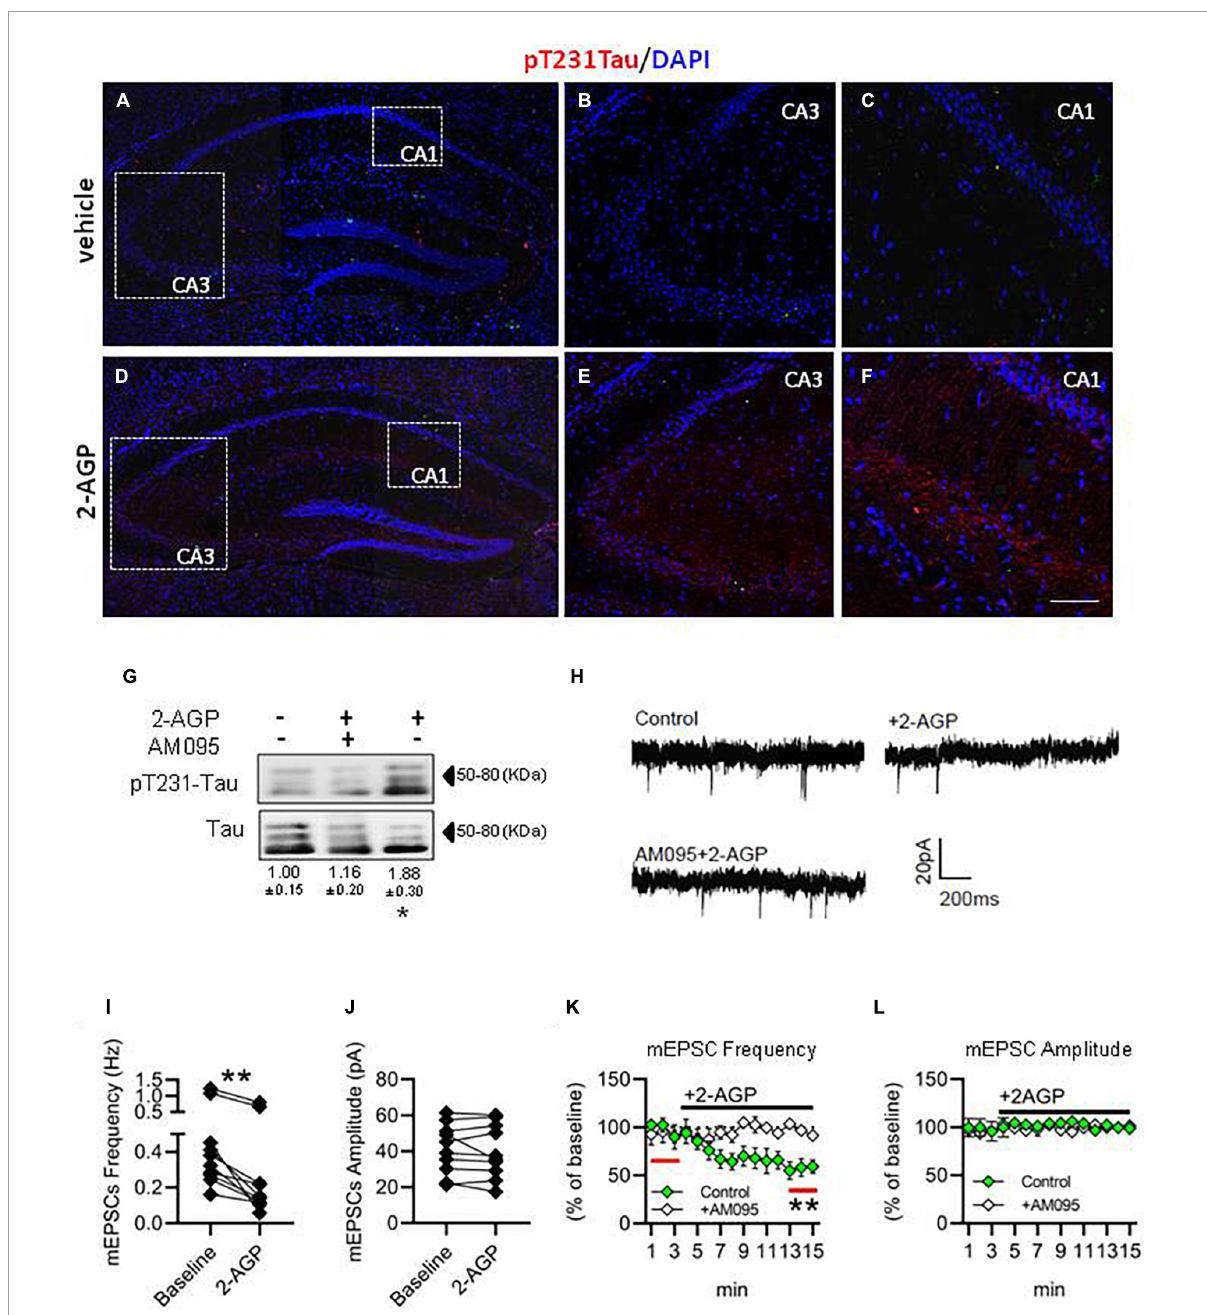
FIGURE4 2-AGP triggers pT231-Tau phosphorylation and impairs glutamatergic transmission in the CA1 area of the hippocampus. (A–F) Representative images of pT231-Tau immunoreactivity in the hippocampus showing the highest expression in the CA3-CA1 area of 2-AGP-injected mice. Panels (B,C,E,F) are high magnification of the respective area selected by the dotted box in the panels (A,D) . Scale bar: 150 µ m in (A,D) and 100 µ m in (B,C,E,F) . (G) Representative immunoblots of pT231-Tau/Tau ratios showing the effect of 2-AGP (10 mg/kg, 1 h) or AM095 treatment (10 mg/kg), injected, 1 h before 2-AGP. Optical density (OD) values are expressed as the ratio between the OD values of phosphorylated and total protein. Data represent means ± SEM ( n = 3 mice/group), * p < 0.05, statistical analysis was performed by ANOVA followed by Tukey’s test. (H) Representative recordings traces of mEPSCs in CA1 pyramidal neurons in control, 2AGP and AM095 + 2-AGP. (I) Graph of the mEPSC frequency before (3 min) (0.48 ± 0.11 Hz) and after treatment with 250 nM 2-AGP (3 min) (0.25 ± 0.08 Hz), Wilcoxon matched-pairs signed rank test. ** p < 0.01, n = 10 neurons in 4 mice (J) Graph of the mEPSC amplitude before (41.28 ± 4.4 pA) and after 2-AGP (40.10 ± 4.7 pA), n = 10 neurons in 4 mice. (K) mEPSC frequency (% of 3 min of baseline). Green: effect of the 2-AGP treatment in CA1 pyramidal neurons, white: effect of the 2-AGP treatment in pyramidal neurons pre-treated with AM095 (10 µ M), statistical analysis was performed by two-tailed one sample t-test, ** p < 0.05; red lines represent the part of compared graph. (L) mEPSC amplitude (% of the baseline). Green: effect of the 2-AGP treatment in CA1 pyramidal neurons, white: effect of the 2-AGP treatment in pyramidal neurons pre-treated with